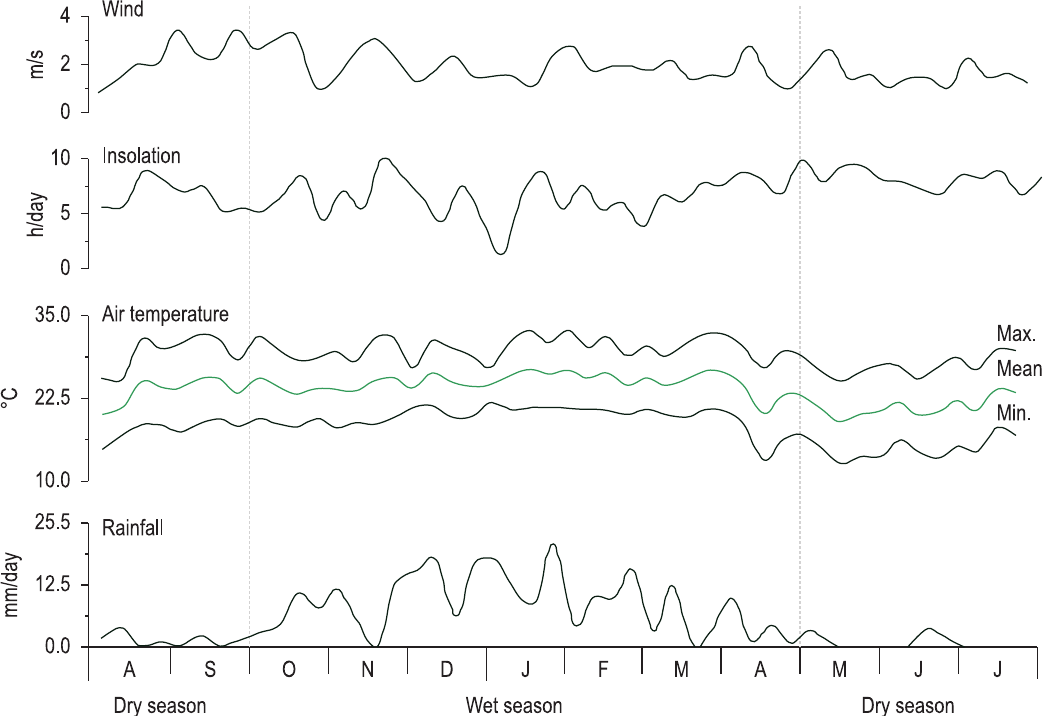
Figure 2. Meteorological data of the period from August 1998 to July